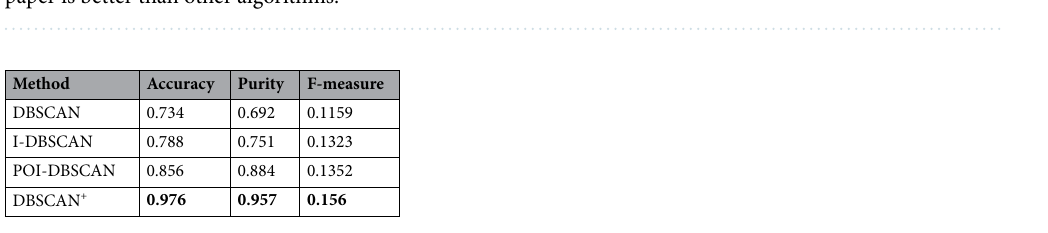
Table 3. The DBI of each density clustering algorithm. The bold indicates that the algorithm proposed in this paper is better than other algorithms.